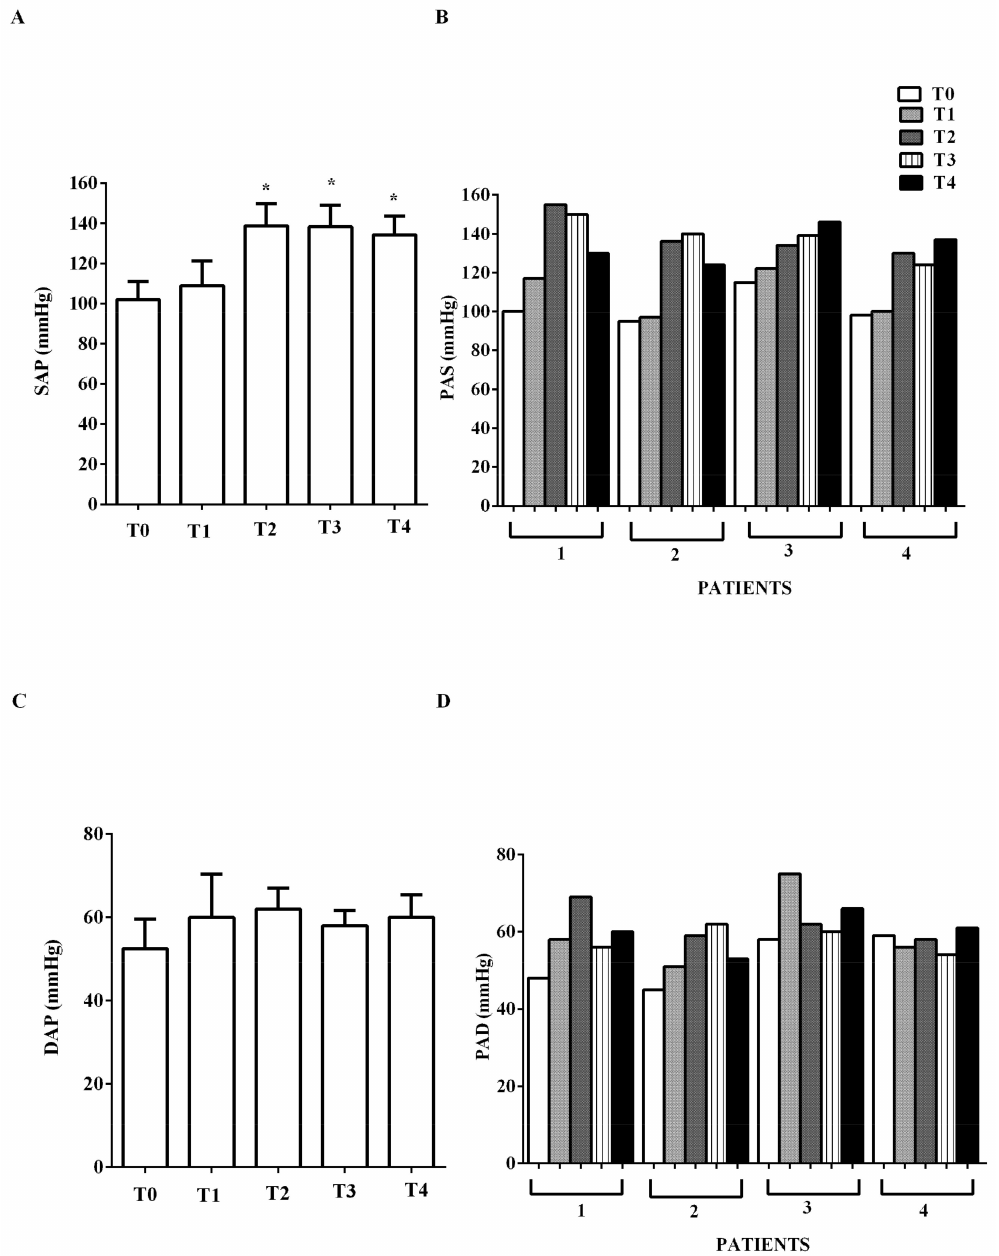
Figure 2. In ( A , B ), e ff ects of levosimendan on systolic (SAP) and in ( C , D ), diastolic (DAP) arterial blood pressure. In A and C, values are means ± SD. In B and D, columns represent single patients. * p < 0.05 vs.